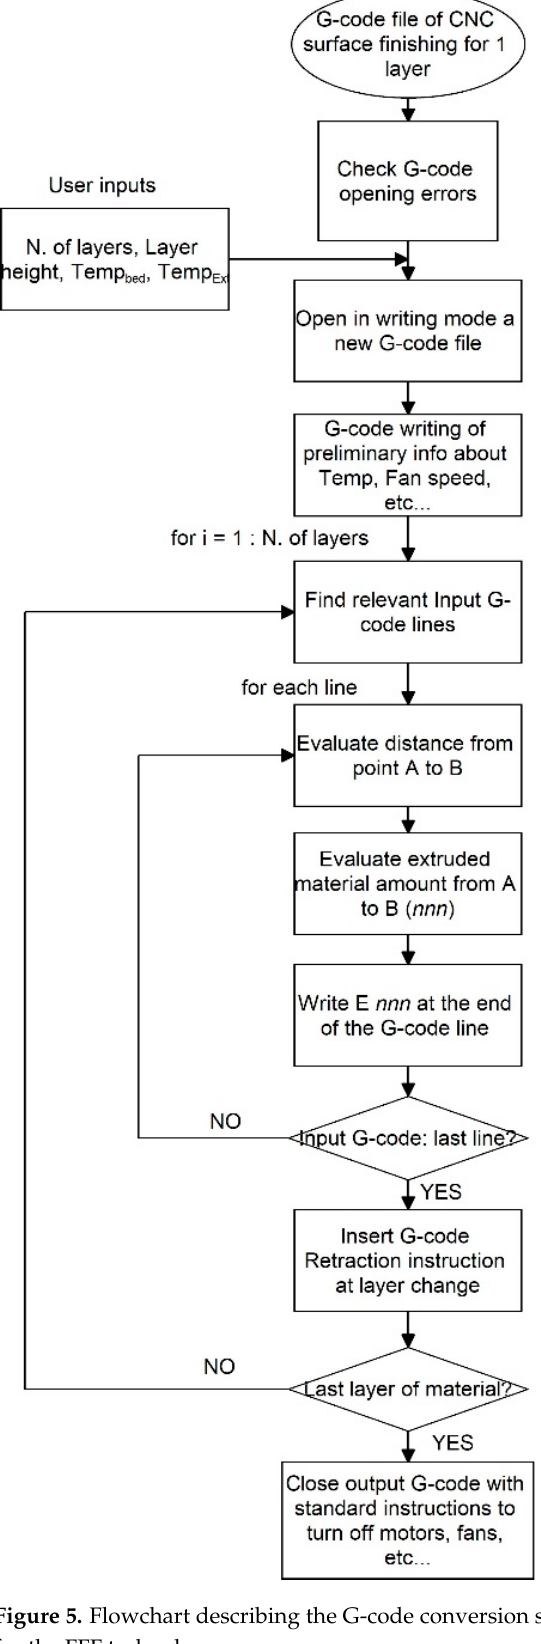
Figure 5. Flowchart describing the G-code conversion script to adapt a virtual finishing instruction for the FFF technology.